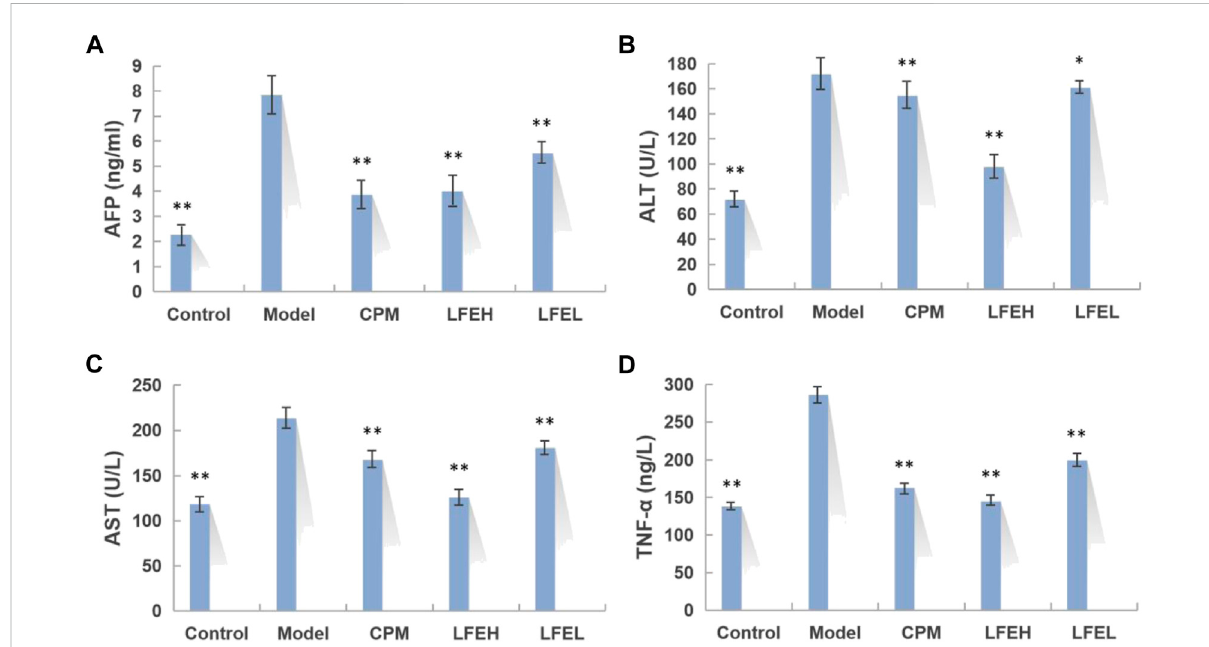
FIGURE 4 Impact of LFE on biochemical indexes of serum in rats with HCC. (A) Content of AFP in each group. (B) Content of ALT in each group. (C) Content of AST in each group. (D) Content of TNF- α in each group. The results were expressed as mean ± SE. n = 8. * p < 0.05, ** p < 0.01 vs. model group. Control, the blank group; Model, the model group; CPM, the cyclophosphamide group; LFEH, LFE high-dose group; LFEL, LFE low-dose